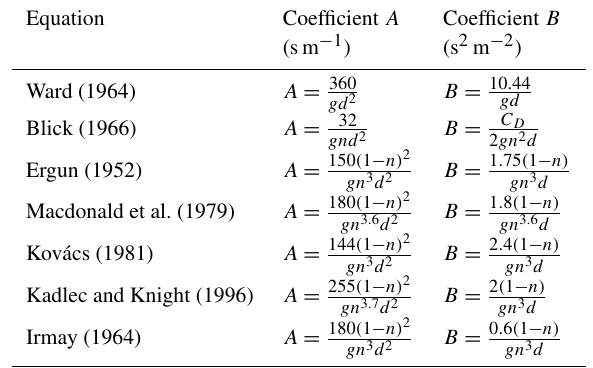
Table 4. The Forchheimer coefficients for empirical